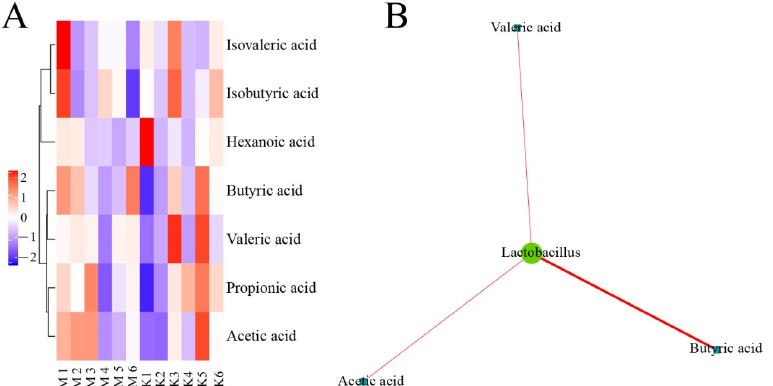
Figure 14. Correlation analysis of intestinal floras and SCFAs in chicken cecum contents between the normal control group and the model group. Note: ( A ) Cluster heatmap of SCFAs between the normal control group and the model group; ( B ) Network of intestinal floras and SCFAs between the normal control group and the model group.